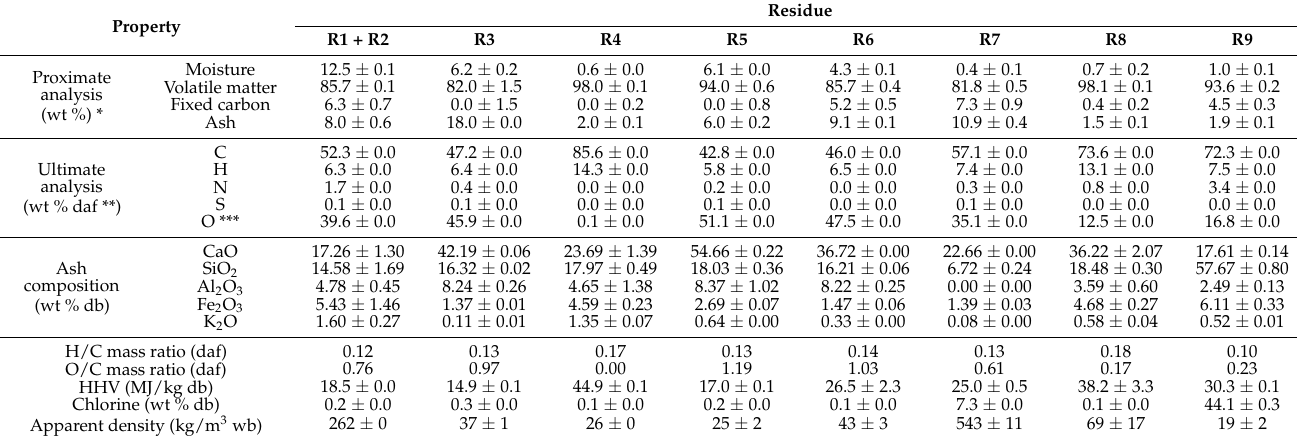
Table 3. Properties of raw individual residues used to prepare